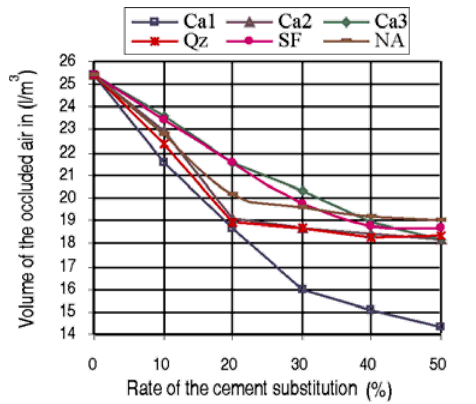
Fig 3. Effect of the cement substitution by mineral admix- tures on the volume of the occluded air in mortars